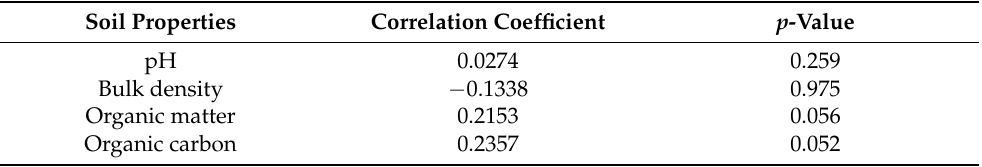
Table 4. Correlations and significant values of the bacterial communities and soil properties deter- mined with the Mantel